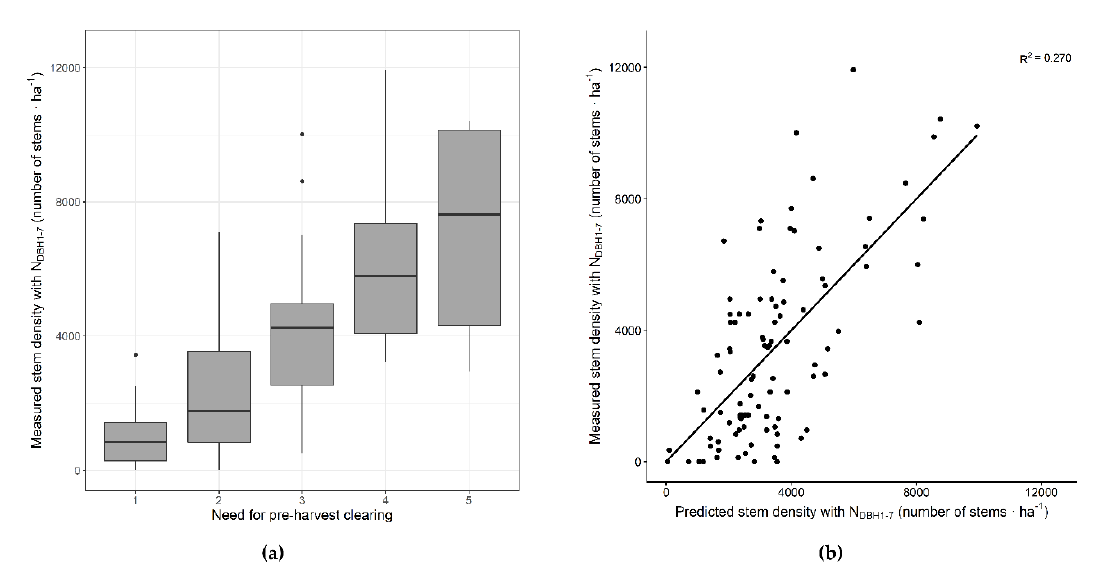
Figure 4. ( a ) Box plots of the measured understory tree densities (trees with diameters at breast height from one to seven centimeters, N DBH1–7 ) versus the need for pre-harvest clearing based on the answers given in the e-questionnaire, being 1, no need for pre-harvest clearing; 2, pre-harvest clearing would help harvesting; 3, pre-harvest clearing recommended; 4, a great need for pre-harvest clearing; 5, compulsory pre-harvest clearing. ( b ) Measured stem densities of trees with N DBH1–7 versus stem densities of trees with N DBH1–7 as predicted by model 1. The solid line is a regression line.